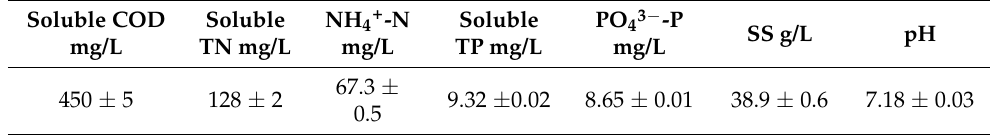
Table 1. Physicochemical indexes of particulate organic matter